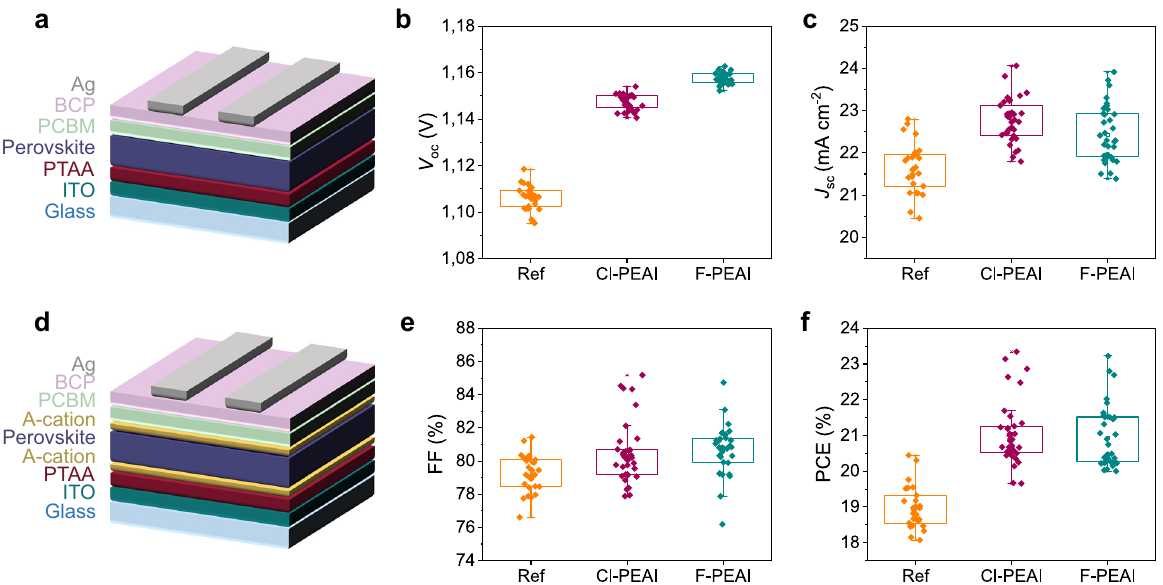
Fig. 1 Electrical characterisation of the samples. a Schematic of the reference samples d Schematic of the A-cation p-i-n devices with dual interfacial modi fi cation. Photovoltaic characteristics of reference (orange), Cl-PEAI (purple) and F-PEAI (teal blue) devices. b Open circuit voltage ( V oc ). c Short